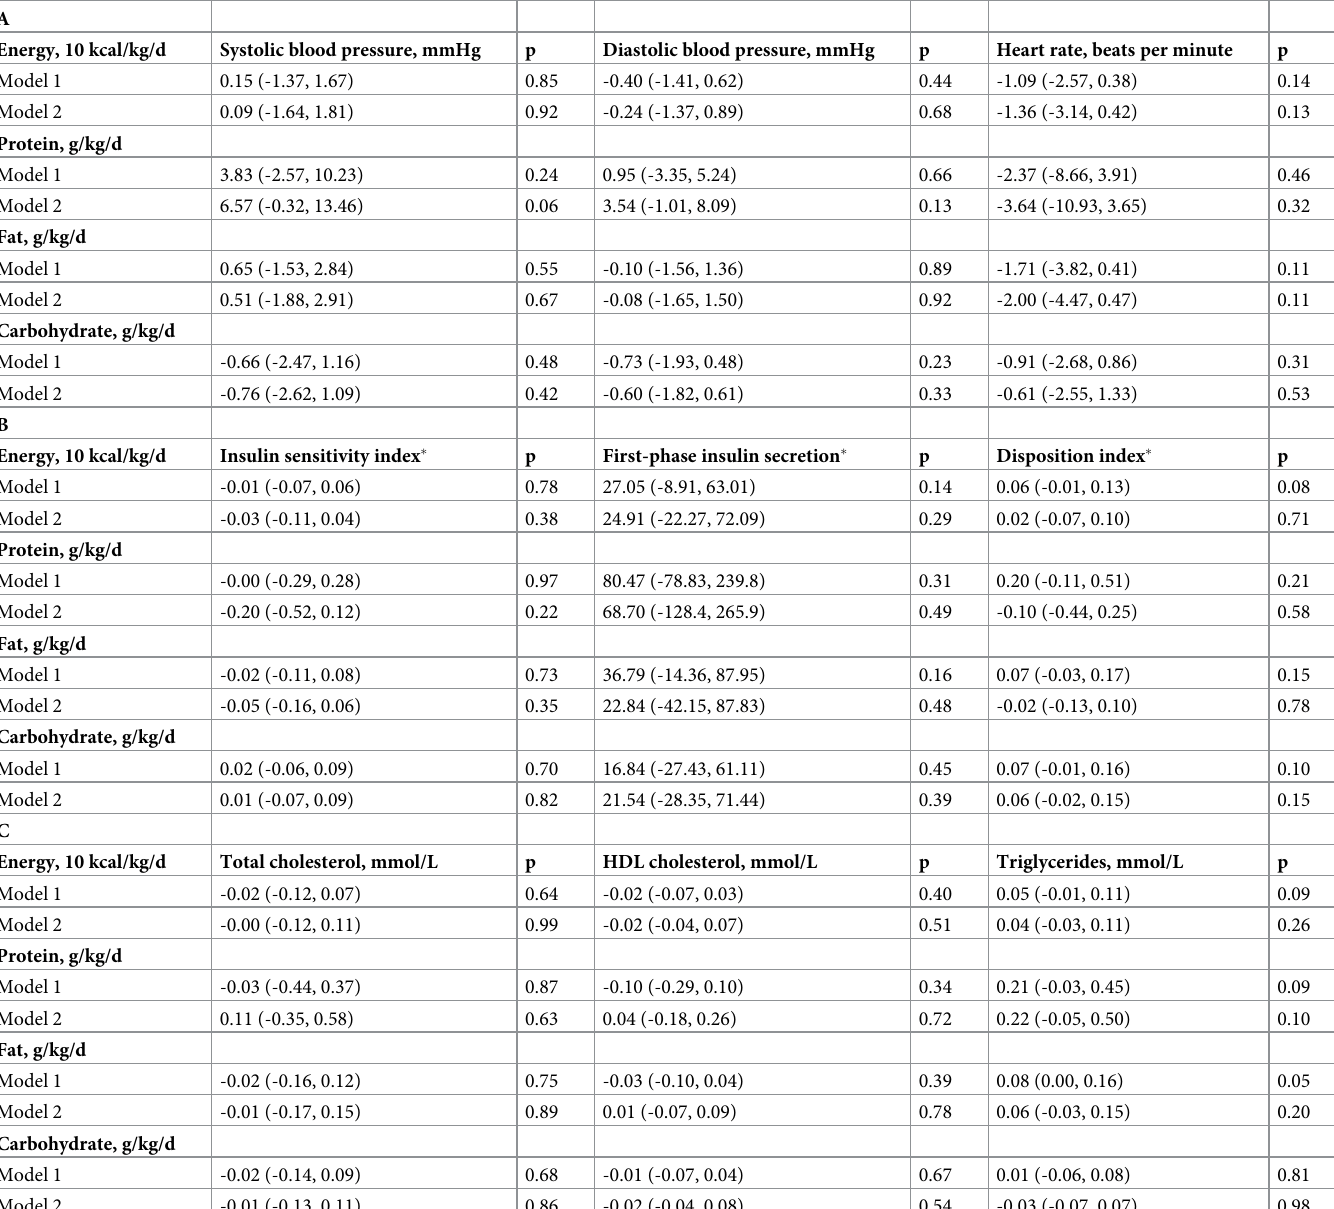
Table 5. Effect of the first 3 weeks of life energy and macronutrient intake of VLBW infants on their A) blood pressures and heart rate, B) insulin sensitivity values and C) lipid concentrations in young adult life, by separate linear regression models.